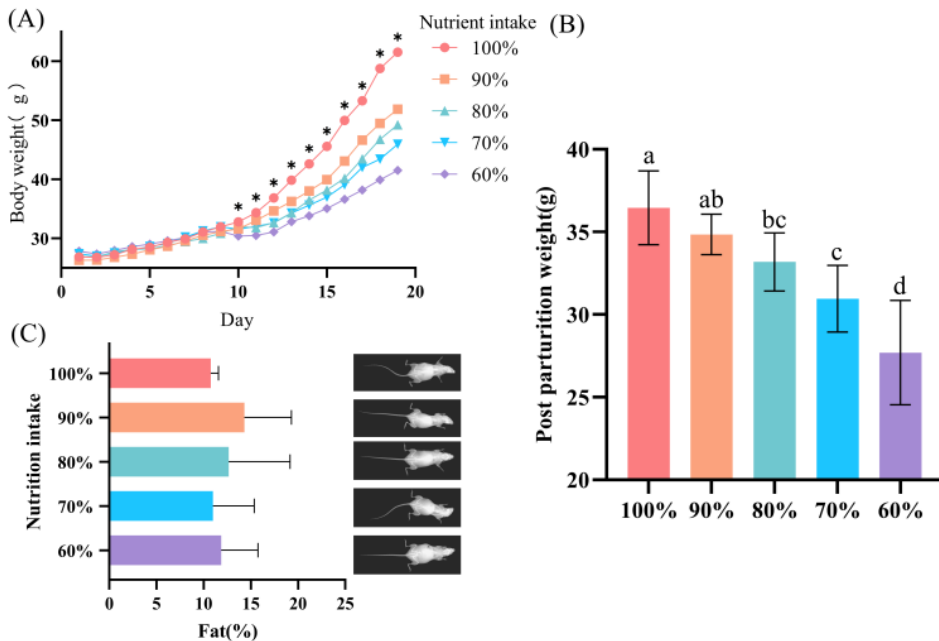
Figure 1. Body weight and body fat of gestational nutritional restriction female mice. ( A ) Body weight of female mice during gestation. ( B ) Postpartum weight of female mice. ( C ) Body fat percentage and X-ray images of female mice after parturition. Identical letters are not significant difference ( p > 0.05), while different letters indicate significant difference ( p < 0.05), determined by one-way ANOVA followed by a Sidak multiple-comparison test. Bar charts represent mean, error bars represent SD. Different colors represent different groups. Asterisk stands for p < 0.05 and no asterisk means no significant